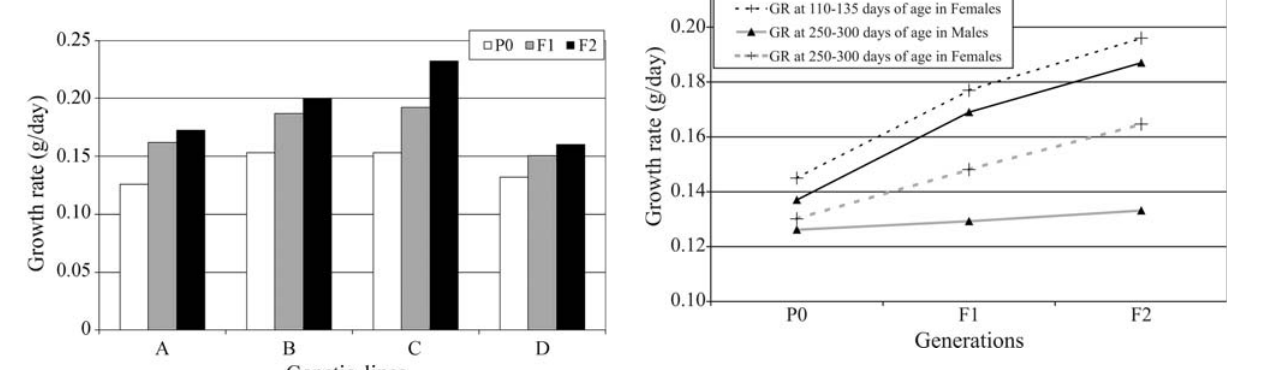
Figure 3 - Growth rate per generation in males and females at two differ- ent ages: 110-135 days (time of harvest and selection) and 250-300 days (when used for